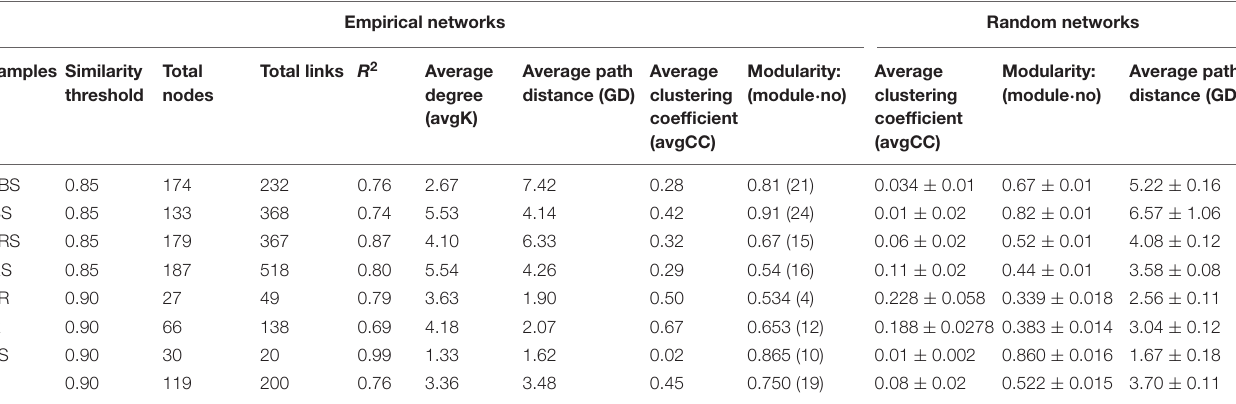
TABLE 1 | Topological features of the soil and endophytic fungal community networks in healthy and infected samples. Empirical